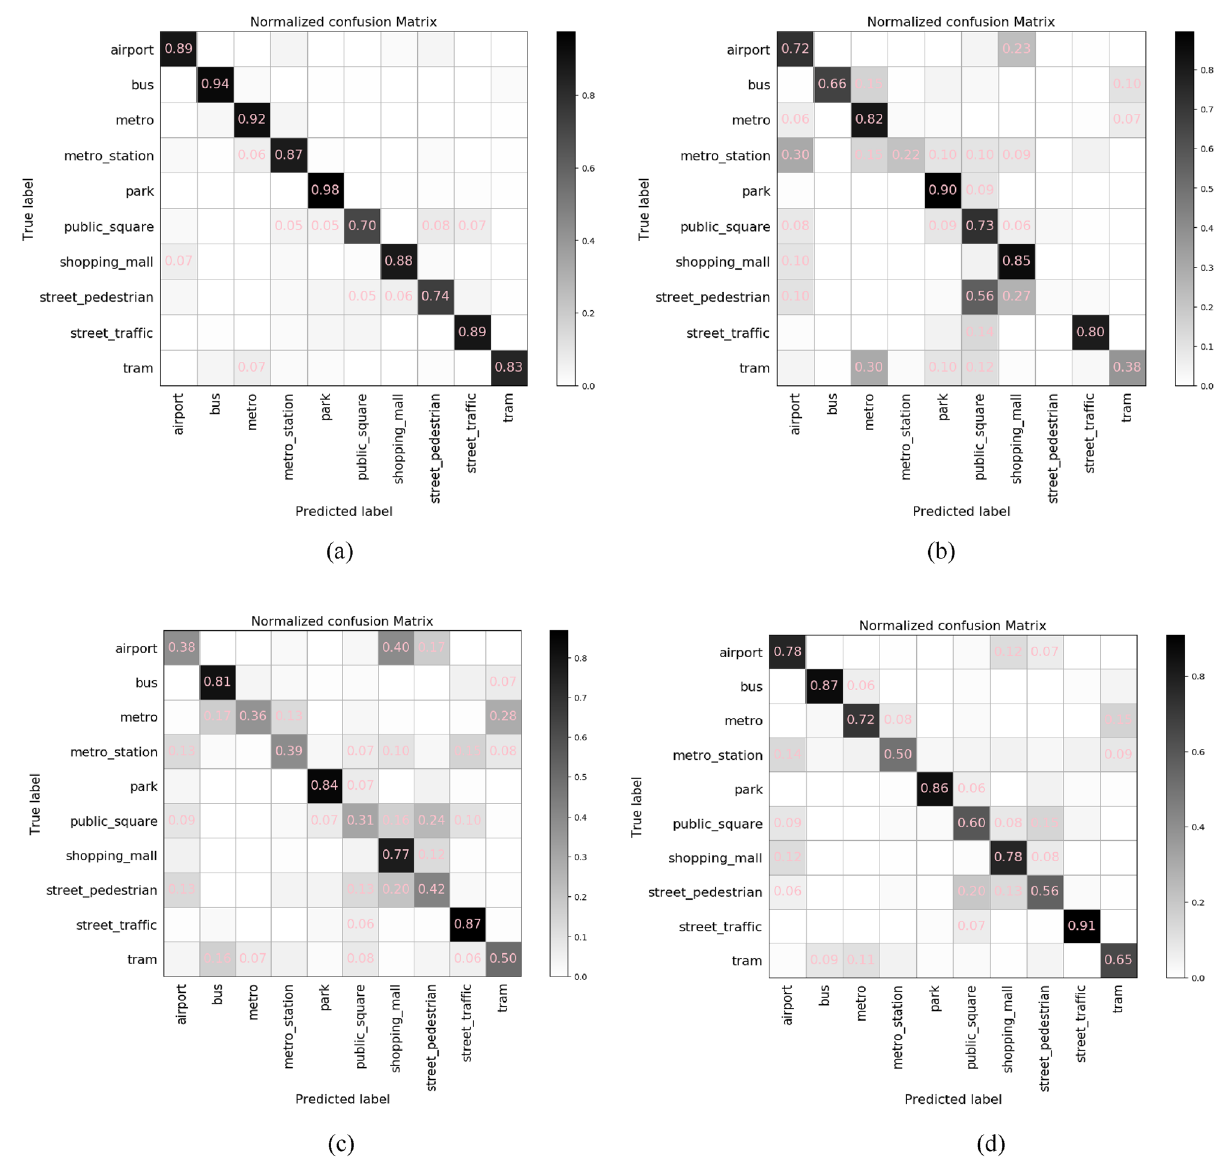
Figure 11. Performance comparison of the proposed approach with other models in terms of confusion matrices. ( a ) Proposed 3D CNN model. ( b ) 1D sequential model. ( c ) 2D ResNet 50 model. ( d ) 2D sequential